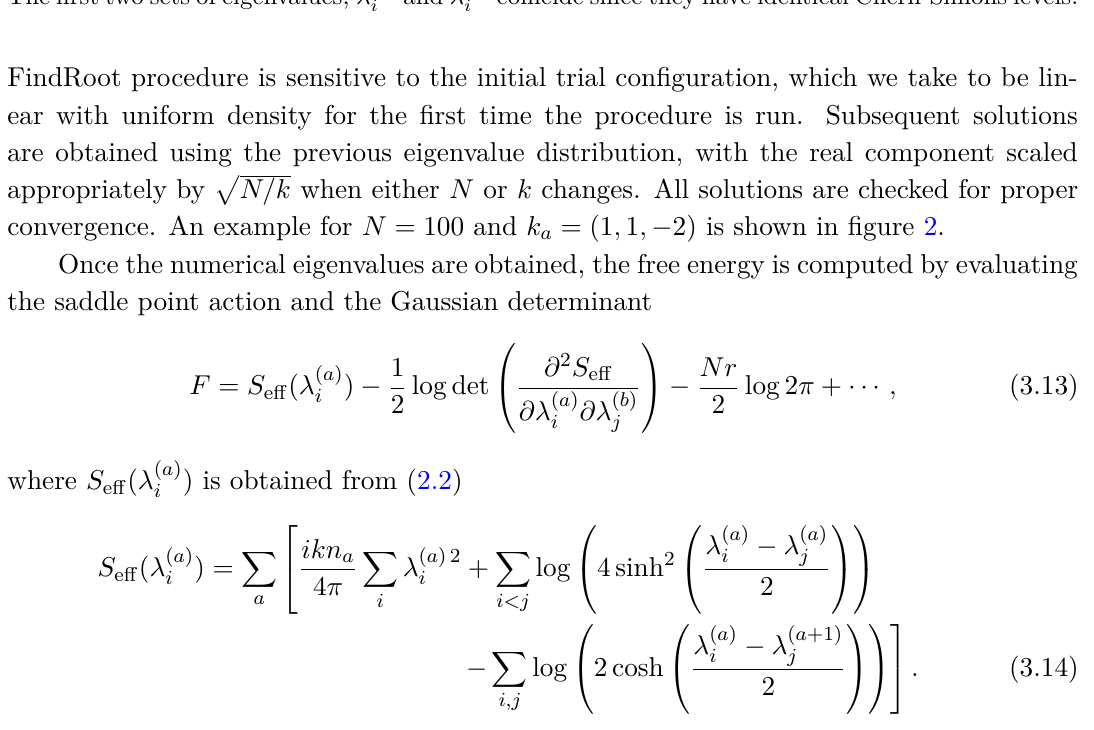
and λ (2) coincide since they have identical Chern-Simons i i